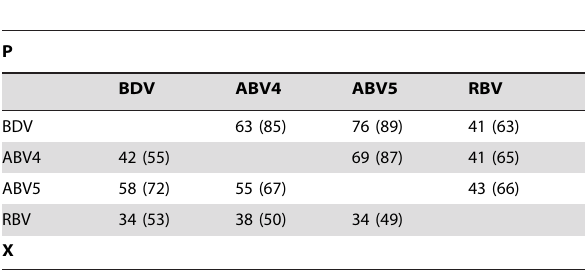
The cells of the upper right and lower left sections show the calculated percentages of amino acid identity (similarity) of P and X proteins among bornavirus genotypes by NCBI BLAST, respectively. Accession numbers used in this study are AB258389 (BDV strain huP2br),